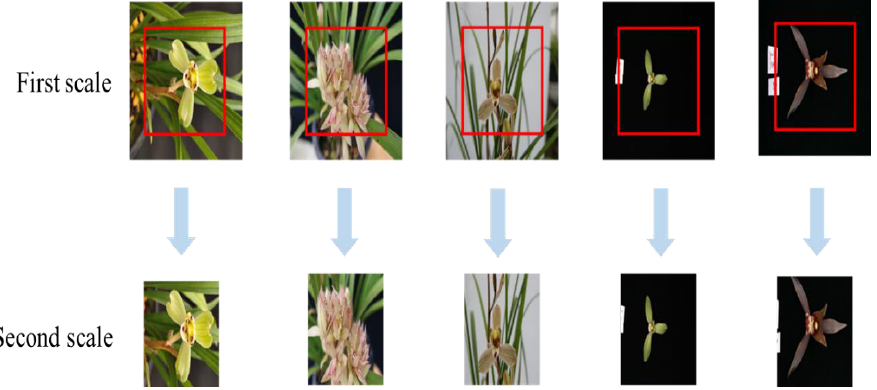
Figure 2. Schematic diagram of two-scale image